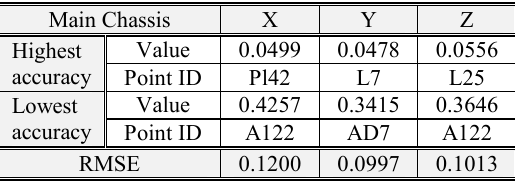
Table 4. Accuracy of points considering RMSE in main chassis.